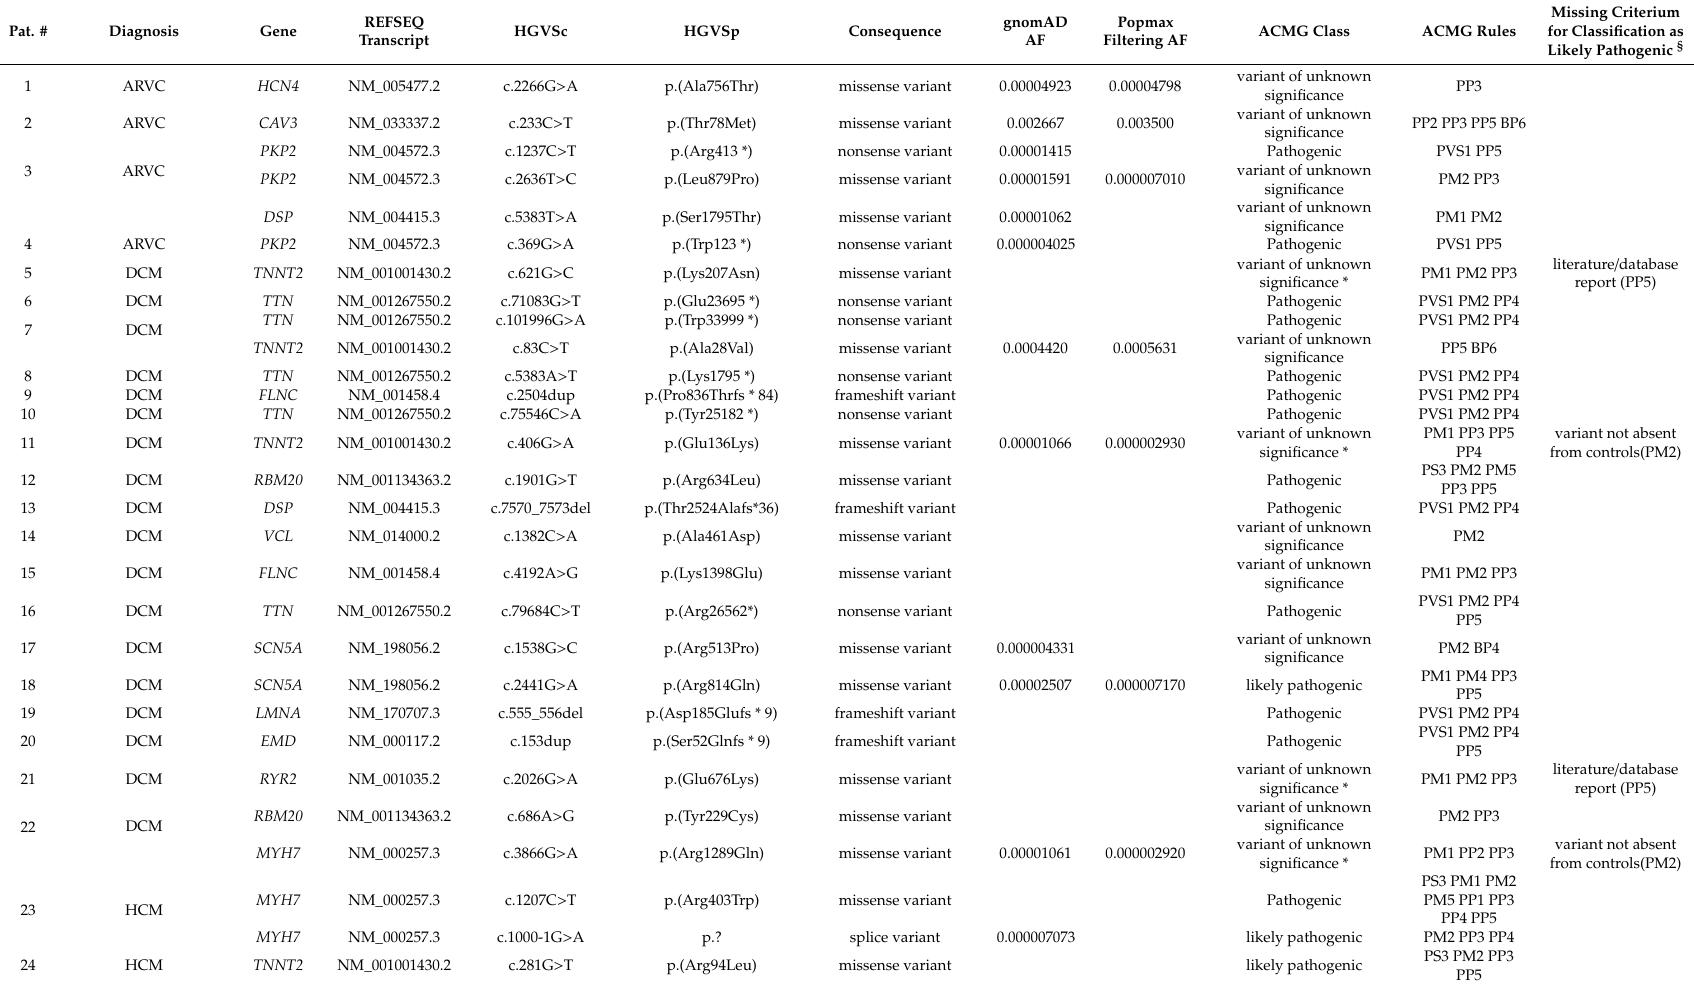
Table 2. Detected variants in genes assigned with a p-OMIM (Online Mendelian Inheritance in Man ® ) number at the time of testing. Pat.